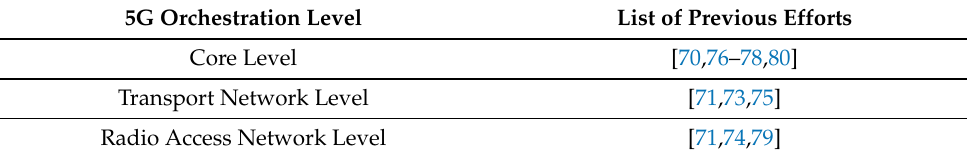
Table 2. Summary of previous efforts—5G orchestration